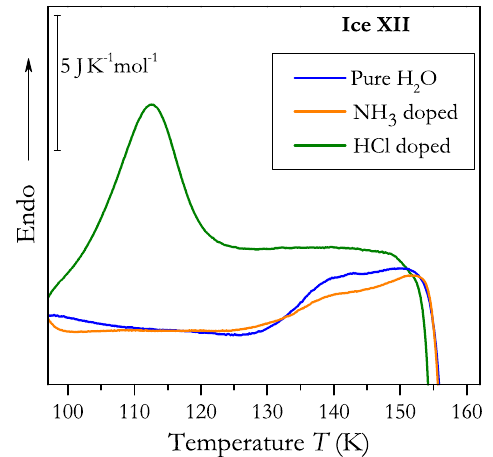
FIG. 1. DSC heating scans recorded at 30 K min − 1 and ambient pressure for doped and undoped ice XII. The signal is normalized to 1 mol. Data taken from Fig. 1 of Köster et al. [25]. The endothermic peak observed for the HCl-doped sample (green trace) represents the transition from hydrogen-ordered ice XIV to hydrogen-disordered ice XII. For the pure water sample (blue trace) and the NH 3 -doped sample (orange trace), the glass transition onset near 130 K indicates that atomic mobility is thawed above this